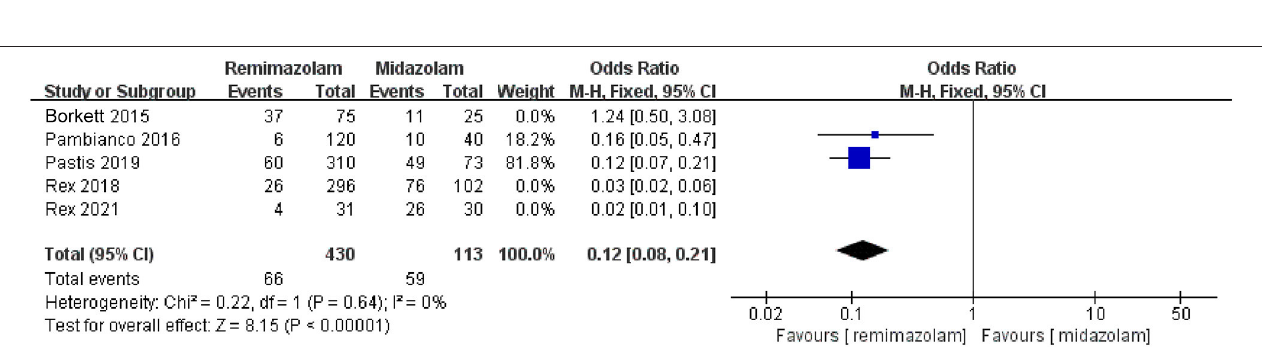
FIGURE 7 | The pooled results of sedative efficacy between remimazolam and midazolam after the sensitivity analysis.